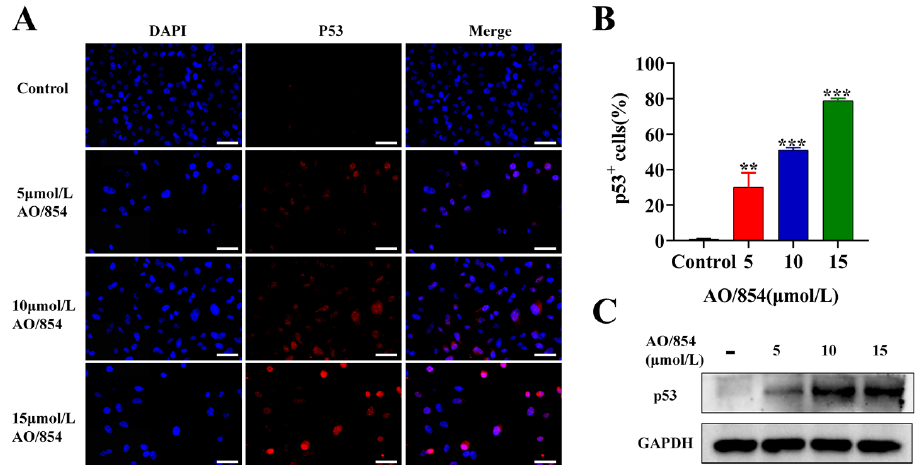
Figure 9. AO/854 reactivated or restored p53 signal pathway in PC3 cells. ( A ) Detection of p53 foci (red) 48 h after AO/854 (5, 10, and 15 μ mol/L) treatment. Scale bars: 50 μ m. ( B ) Quantification of p53 + cells in AO/854 (5, 10, and 15 μ mol/L) ‐ treated groups compared with DMSO ‐ treated group